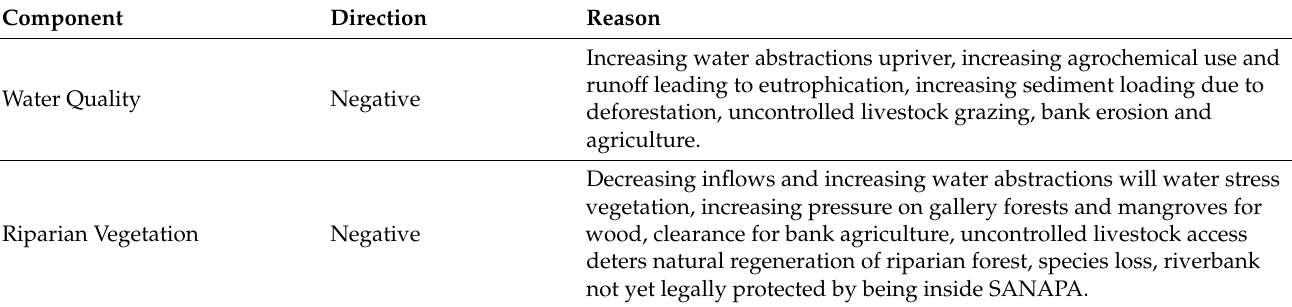
Table 4. Trajectory of change in various ecosystem